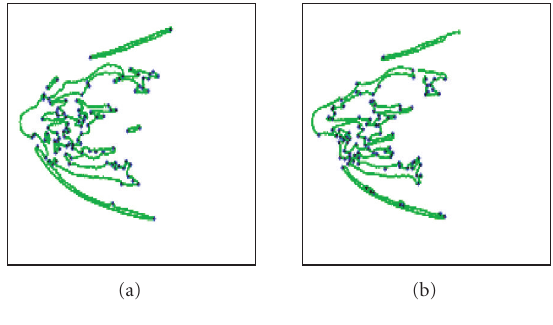
Figure 5: Extracted fibroglandular tissue with corner pointed de- tected: (a) precontrast image, and (b) postcontrast